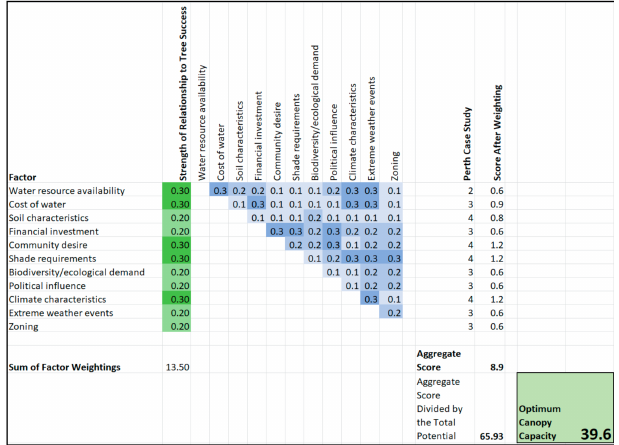
Figure 2. Snapshot of the